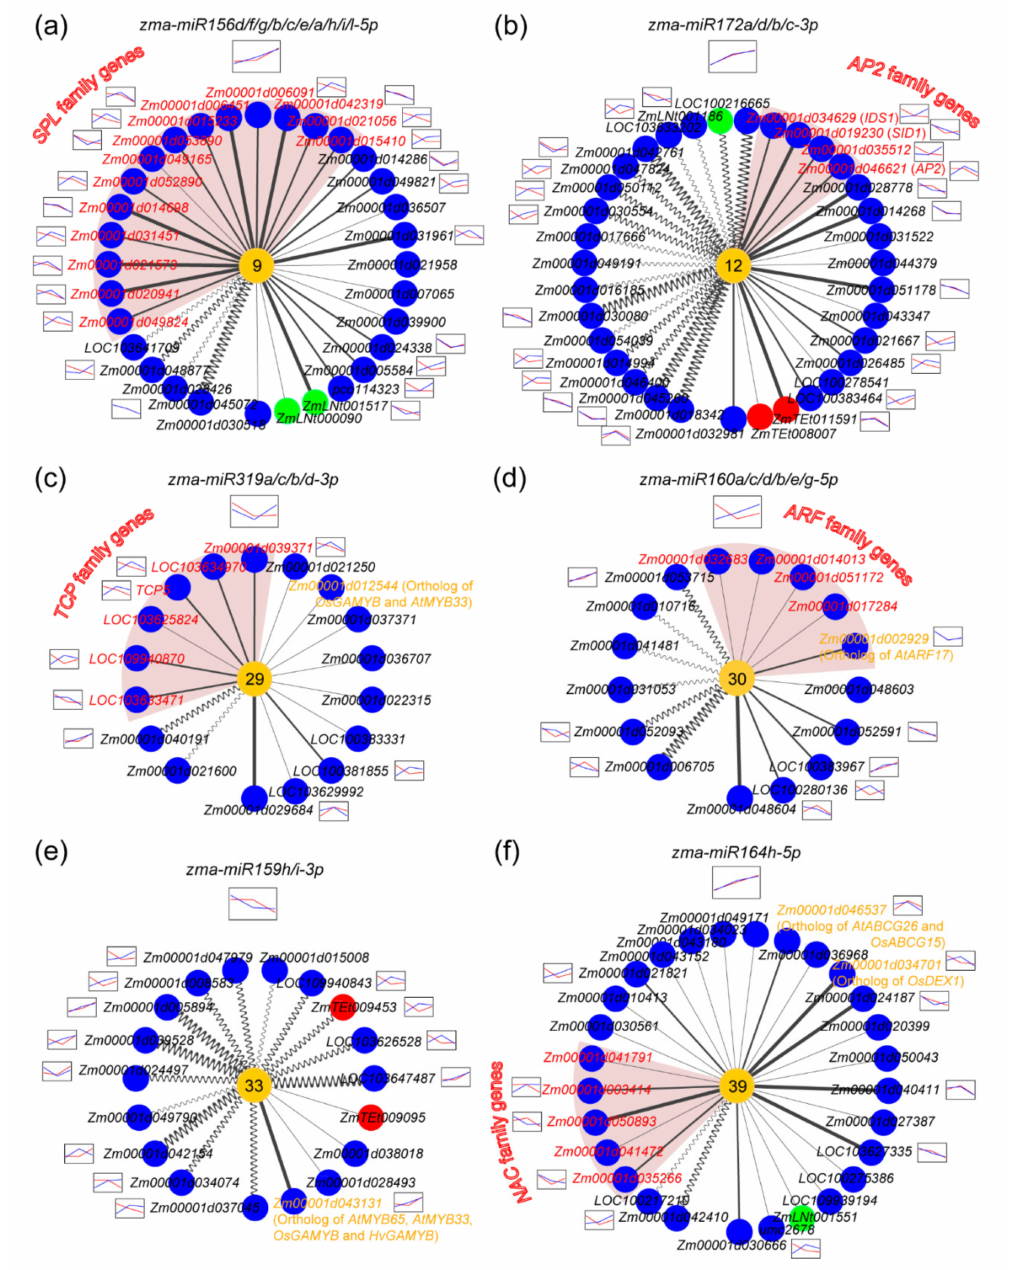
Figure 6. The six known miRNA-mediated regulatory networks functionally associated with maize anther development. The six networks mediated by the known miRNAs of ( a ) zma-miR156 , ( b ) zma-miR172 , ( c ) zma-miR319 , ( d ) zma-miR160 , ( e ) zma-miR159 , and ( f ) zma-miR164 are shown. The transcription expression patterns of corresponding miRNAs are shown at the top of the networks based on small RNA transcriptomes in maize lines L7 (marked in red curve) and L30 (marked in blue curve). The transcription expression patterns of ceRNA or target genes that were negatively associated with miRNA expression in at least one line are shown beside them. The names and the backgrounds of target genes in the same gene family in each network are marked in red. The names of genes with orthologs that participate in anther development in other plant species are shown in yellow. Other legend of this figure is the same as that of Figures 4 and